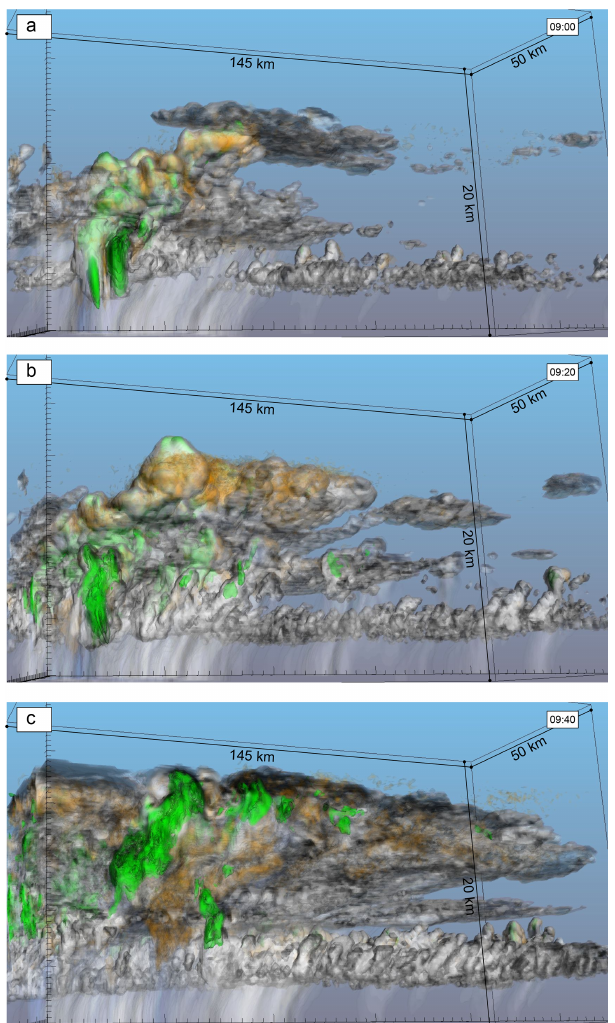
Figure 15. Three-dimensional rendering of the simulated convec- tive cell from HR150 between 09:00 and 10:00UTC, in terms of rainwater, cloud water, graupel, snow aggregate, and ice water contents. Panels also show updraughts exceeding 5ms − 1 (green colour) and downdraughts stronger than 2ms − 1 (orange colour).